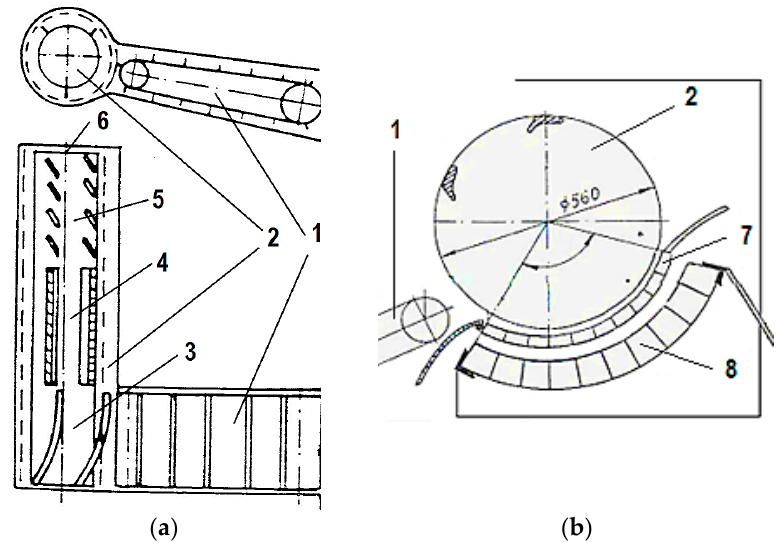
Figure 1. Constructive schemes of the experimental installation. ( a ) The axial threshing apparatus. ( b ) Cross section through the threshing apparatus. 1—material feeding system; 2—threshing machine with axial flow; 3—material feeding area; 4—threshing area; 5—seed separation area; 6—the discharge area for threshed straws and ears; 7—counter-rotor; 8—combined casing-cleaning system.